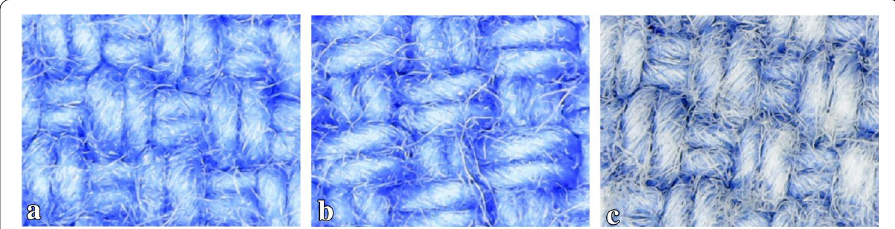
Fig. 9 Digital microscopic view of different treated canvas surface garments at 225X a AD (After Dyeing), b AE (After Enzyme), c APN (After PP Followed by PP Neutralization)